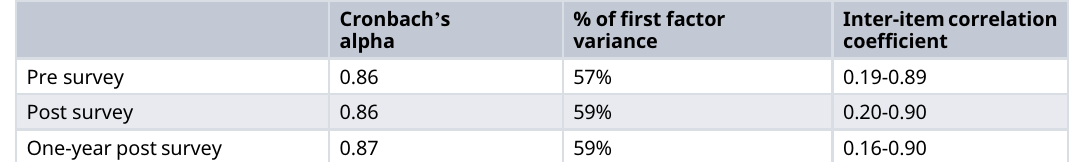
Table 4. Specification of the